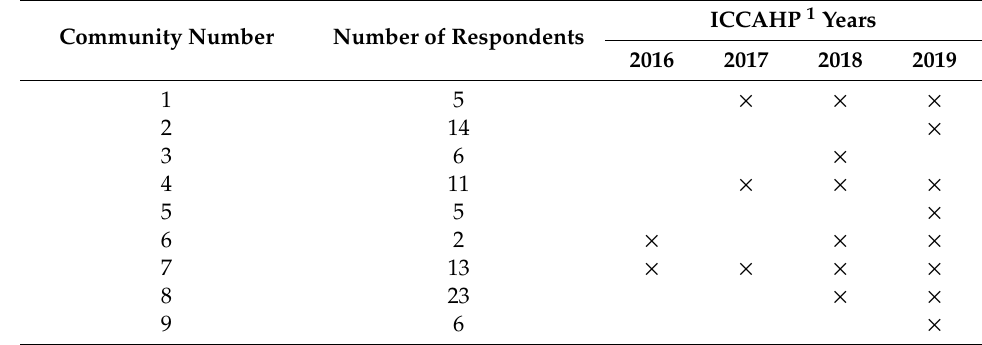
Table 1. Dog owners interviewed from each of nine Australian Aboriginal communities and the year communities received the dog health